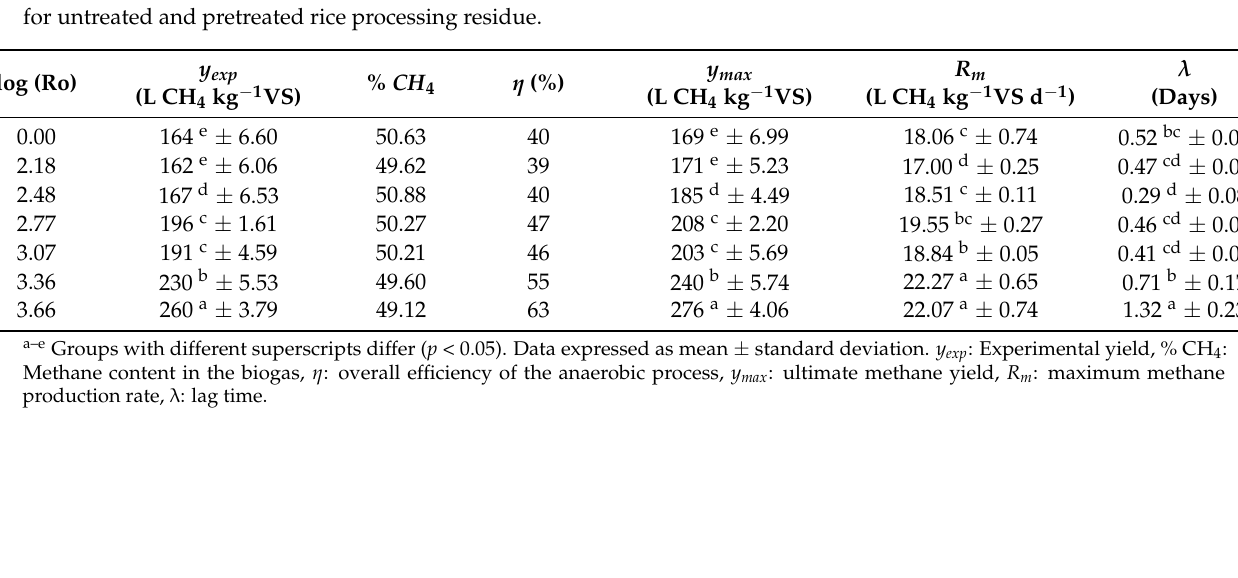
Table 3. Experimental and ultimate methane yield, conversion efficiency, maximum methane production rate and lag time for untreated and pretreated rice processing residue. log (Ro)